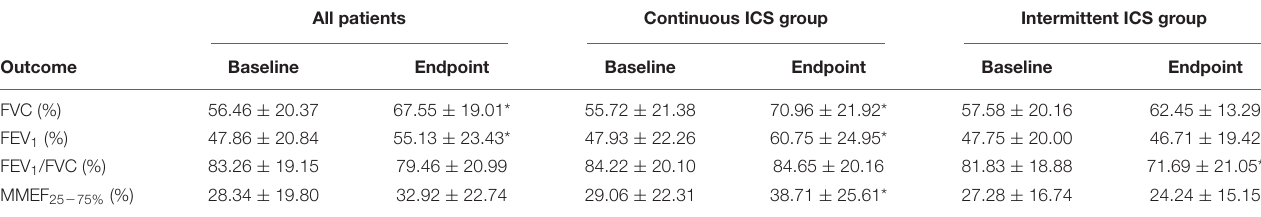
*represents p < 0.05.